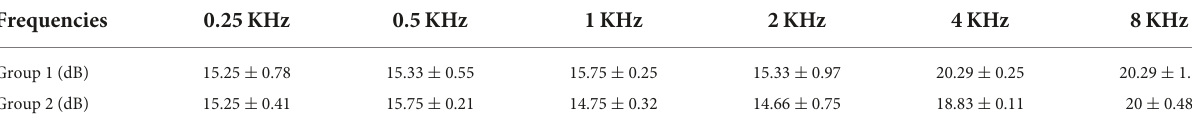
TABLE 6 The average postoperative differences in A-B gap of patients with type I labyrinthine fistulas in group 1 and group 2. Frequencies